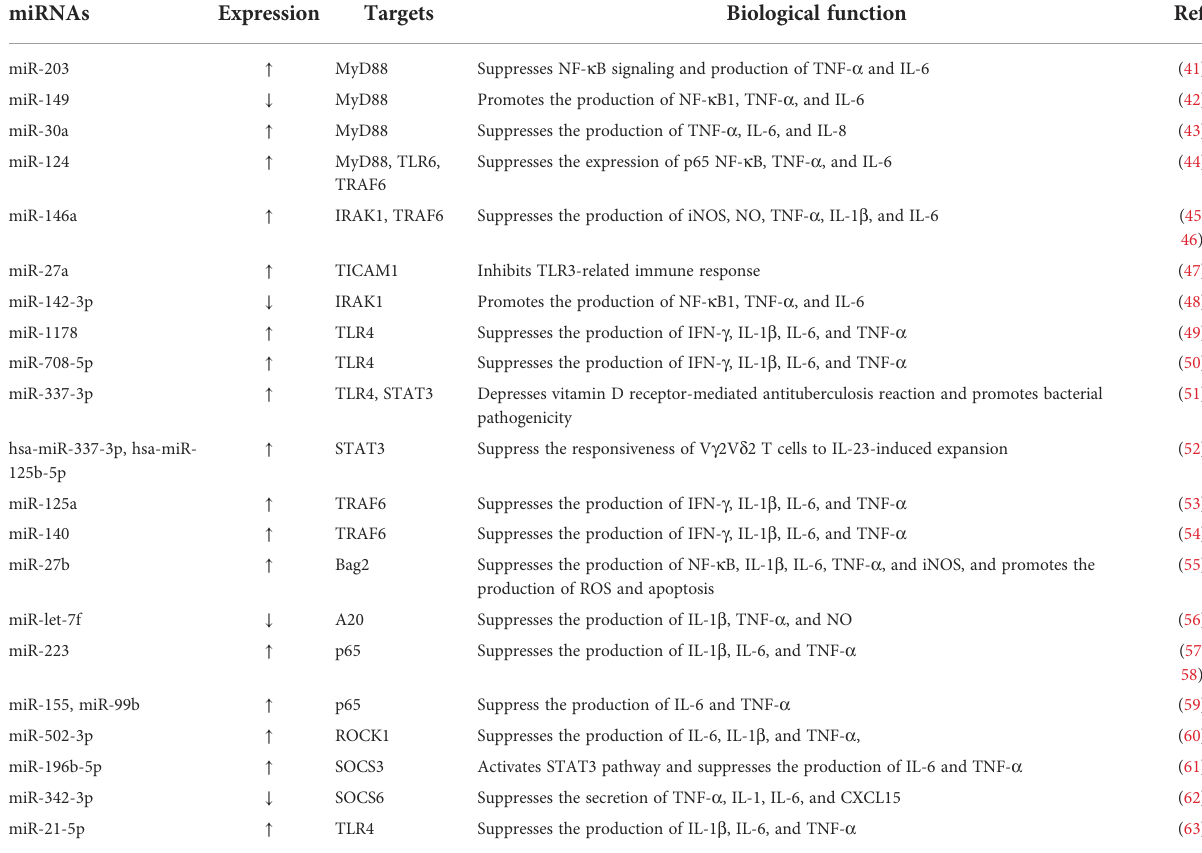
TABLE 1 MicroRNA-regulated signaling pathways in tuberculosis.